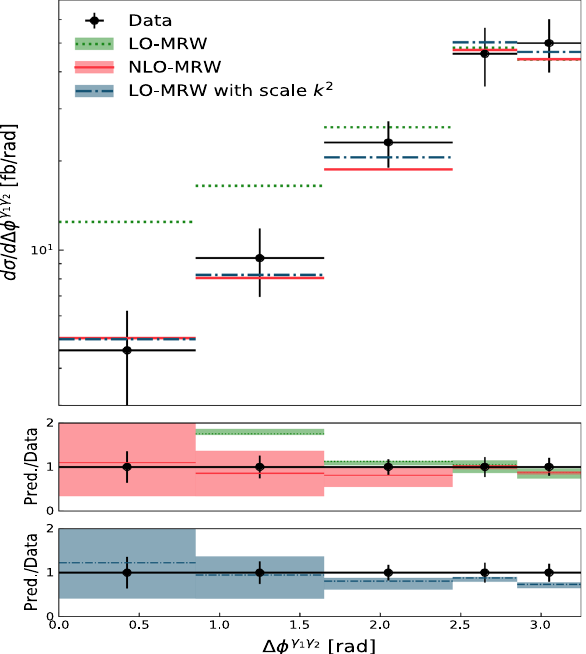
Fig. 10 The comparison of the scale uncertainty between the LO- MRW, NLO-MRW and LO-MRW differential cross sections with scale k 2